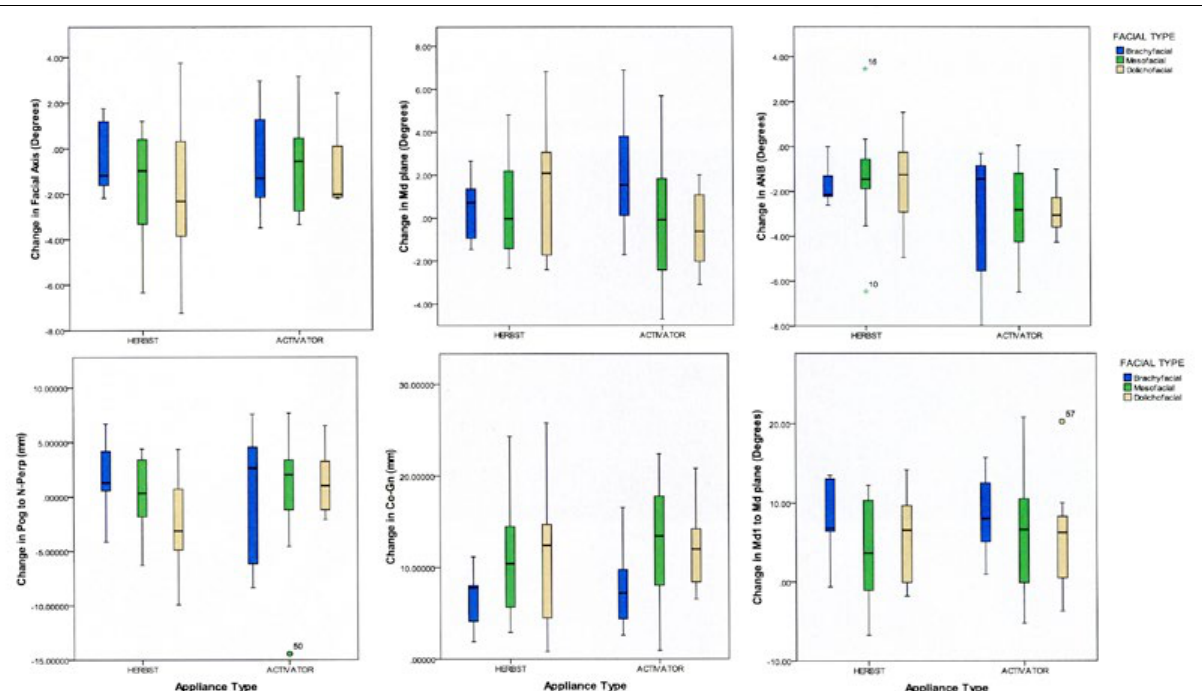
Figure 1. Cephalometric changes with two-phase